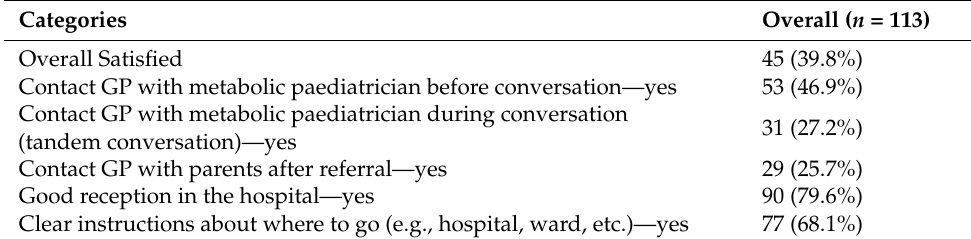
Table 1. Summary of closed ended